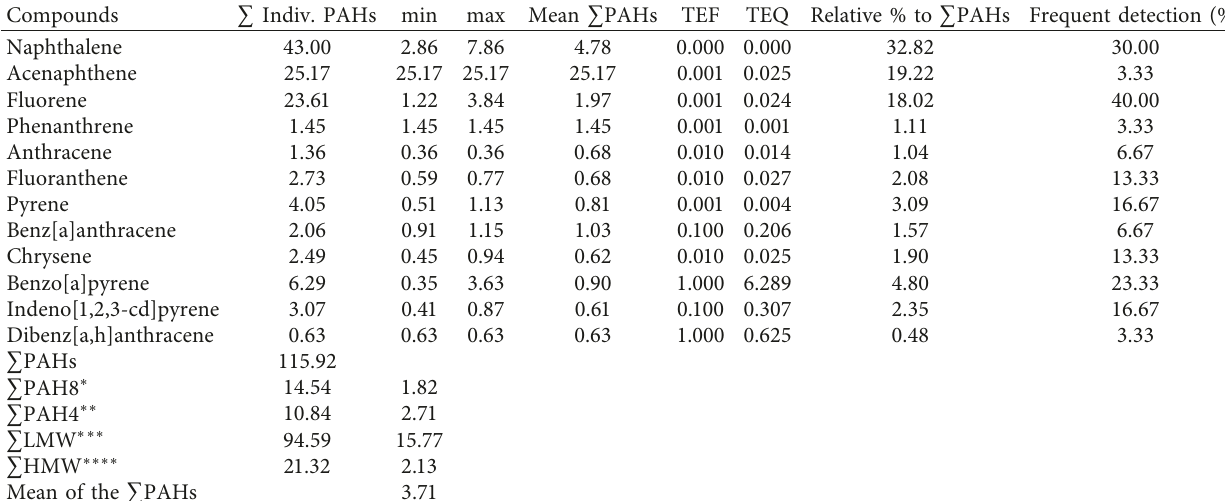
Table 5: Mean concentration of PAHs, 􏽐 PAHs, TEF, TEQ ( 􏽐 B[a]Peq), and relative % to 􏽐 PAHs (ng/g wet/wt).